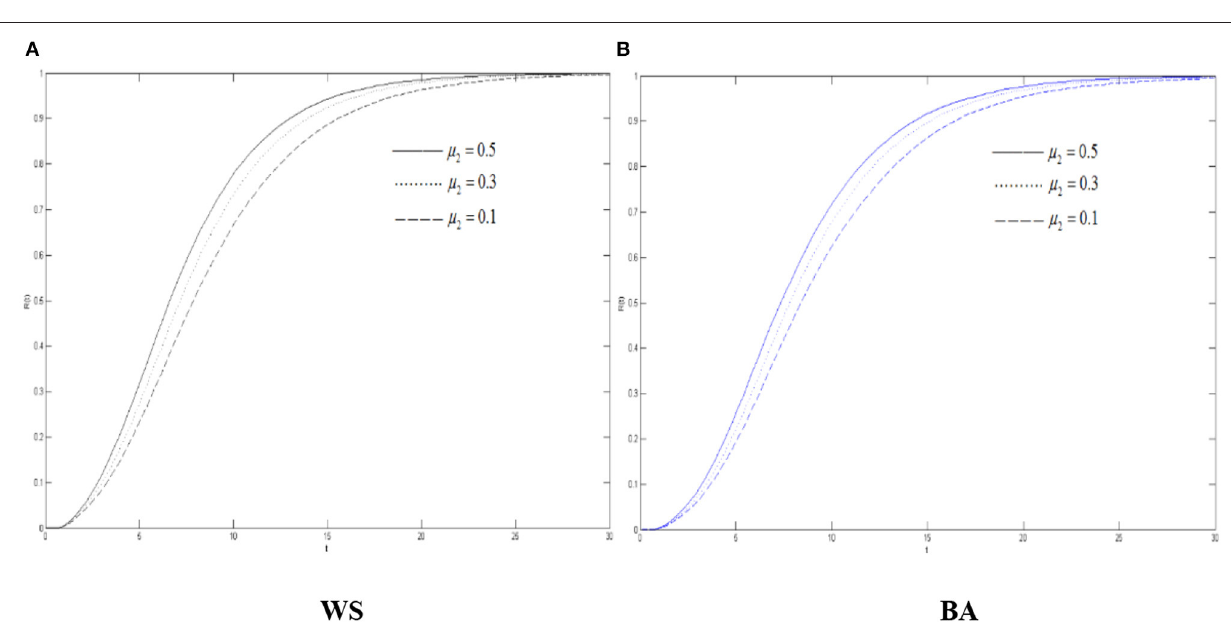
FIGURE 6 | The differences of the recovery density in WS small world and BA scale-free network when µ 2 changes. (A) WS, (B)